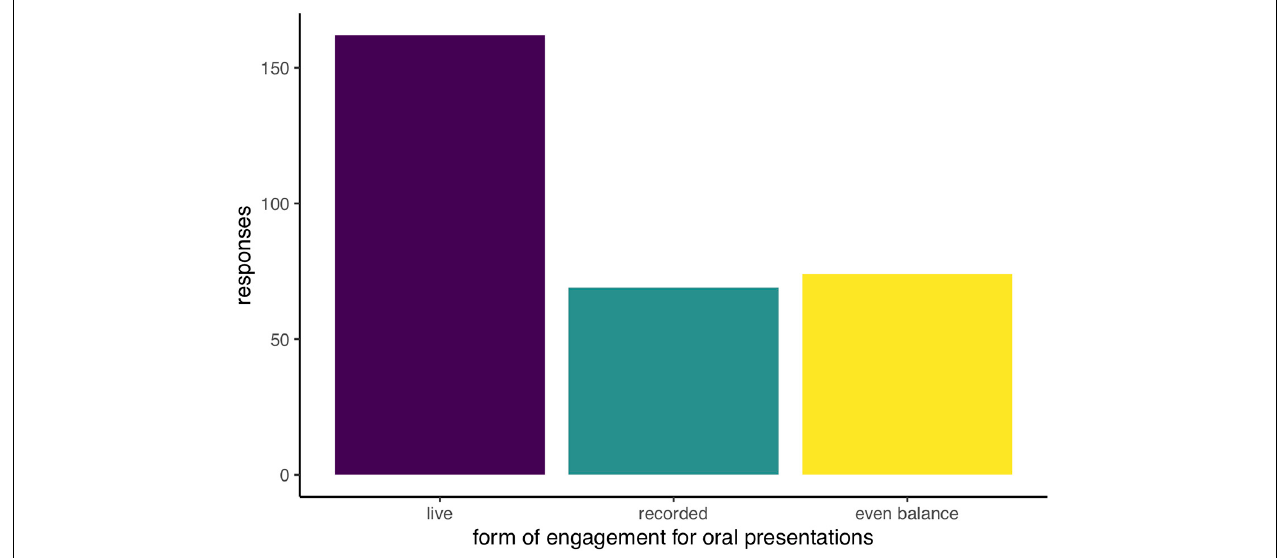
FIGURE 5 | Distribution of the majority of survey respondents’ engagement with the oral